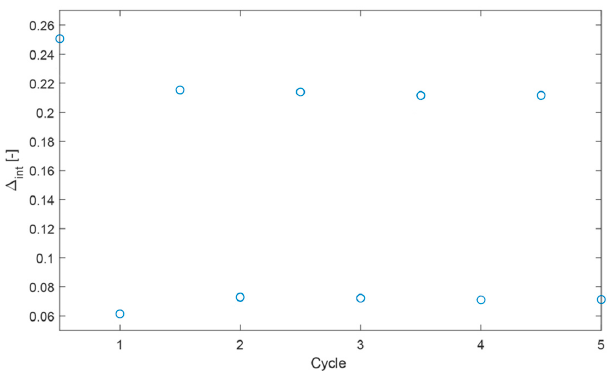
Figure 7. Plot showing temperature-cycle measurements for α -MoO 3 :Eu 3+ , Tb 3+ . Temperature-dependent upconversion luminescence measurements were also performed on the α -MoO 3 :Er 3+ , Yb 3+ sample. The α -MoO 3 :Er 3+ , Yb 3+ material showed temperature-sensing behavior in the high-temperature range, but not in the cryogenic range. The room temperature emission spectrum and the temperature evolution of the emission spectra in the temperature range of 273 – 373 K are shown in Figure 8a,b, respectively. The intensity of two emission peaks decreased with the increase of temperature, since the increase of temperature enhances the probability of nonradiative transition, leading to the luminescence quenching. The color did not change in this particular temperature range, and the CIE coordinates shown in Table S7 are indexed to a CIE diagram in Figure 8c. The maximum intensity of peaks at 530 nm ( 2 H 11/2 → 2 H 15/2 transition) and 552 nm ( 4 S 3/2 → 4 I 15/2 transition) of Er 3+ were used to calculate ∆. The data could be well fitted with Equation (2) for single-center thermometers (Figure 9a, R 2 = 0.994), yielding parameters α = 14.74, ∆E = 565.86 cm −1 , which is close to the theoretical calculated value (energy difference between 2 H 11/2 and 4 S 3/2 : 727 cm −1 ). Figures 9b and S10 show S r and S a as a function of temperature, respectively. The maximum value of S r is 1.092% K −1 (at 273 K), and S a is 0.00972 K −1 (at 273 K). Since the monitored peaks of Er 3+ overlapped at 538 nm, when ∆ was determined considering the integrated area under the peaks a worse R 2 value of 0.987 was obtained. Temperature-cycle tests are shown in Figure 10 proving that the material gives excellent repeatability (R = 98%).